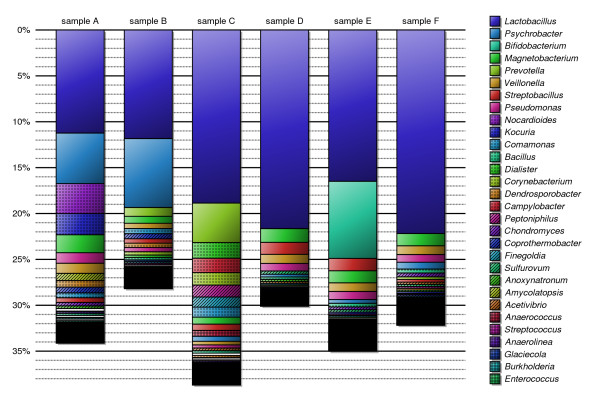
Top identified genera in samples. The top 30 genera identified in all six samples are listed in descending order. The percentages of reads in each sample belonging to these genera are indiecated by the height of the bar.